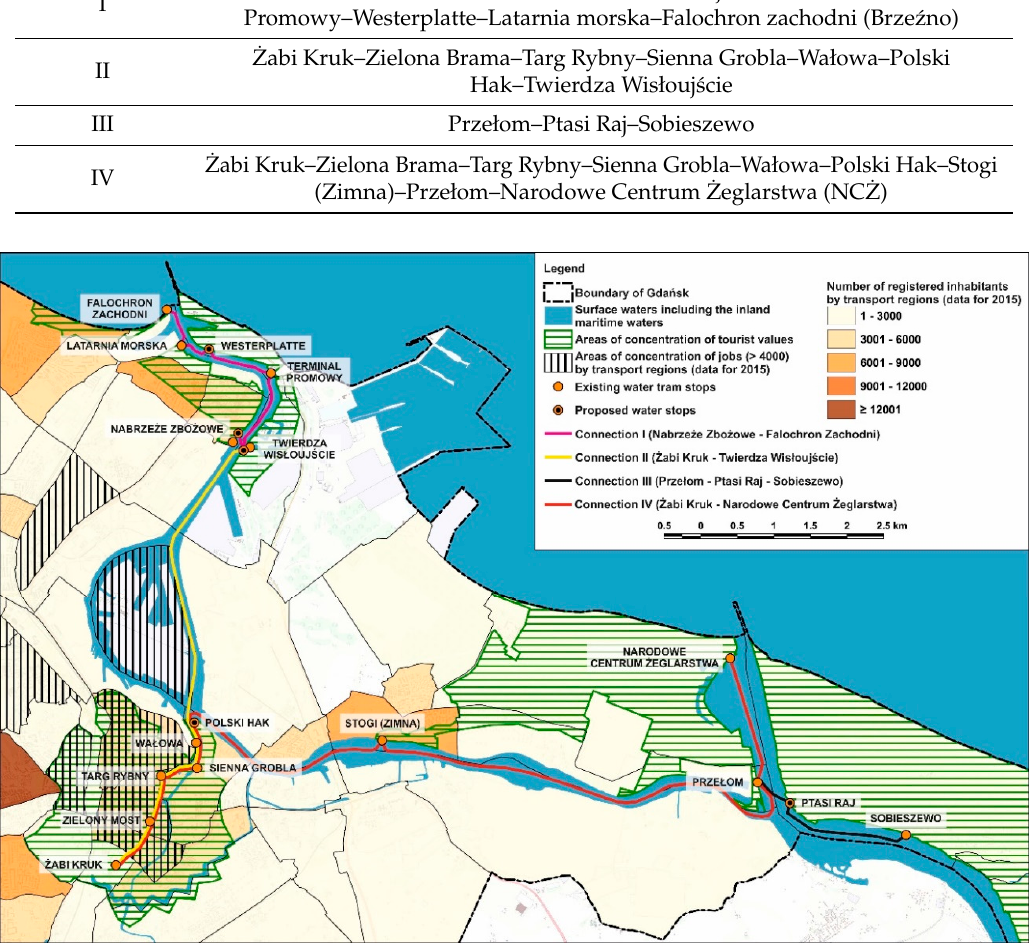
Table 3. Characteristics of the proposed water tram lines in Gda ń sk.